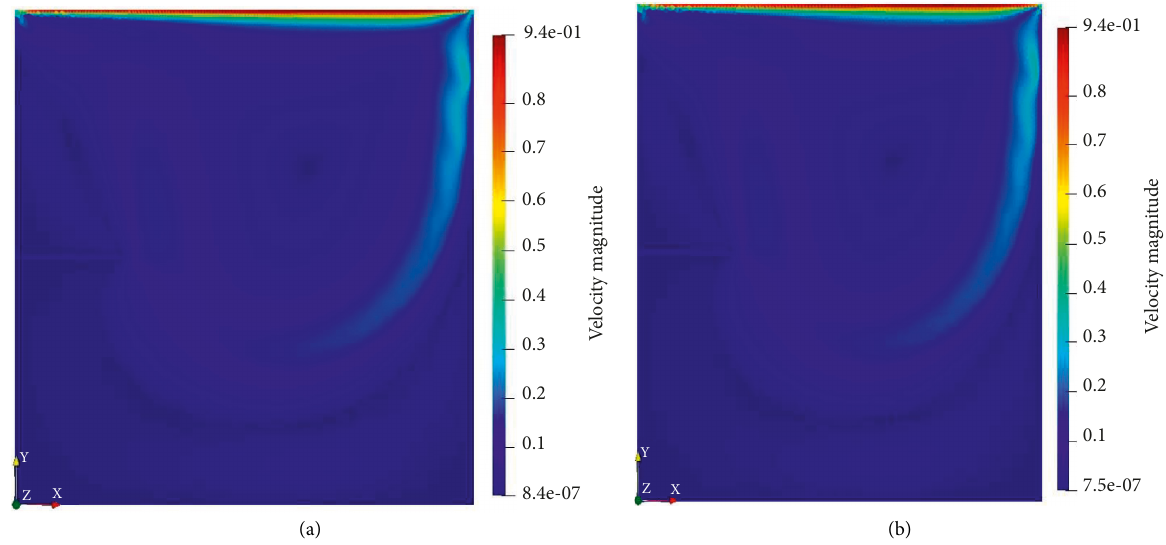
Figure 3: Velocity magnitudes in case of Re � 5000 and for Rf � 0 (a), Rf � 1 × 10 − 4